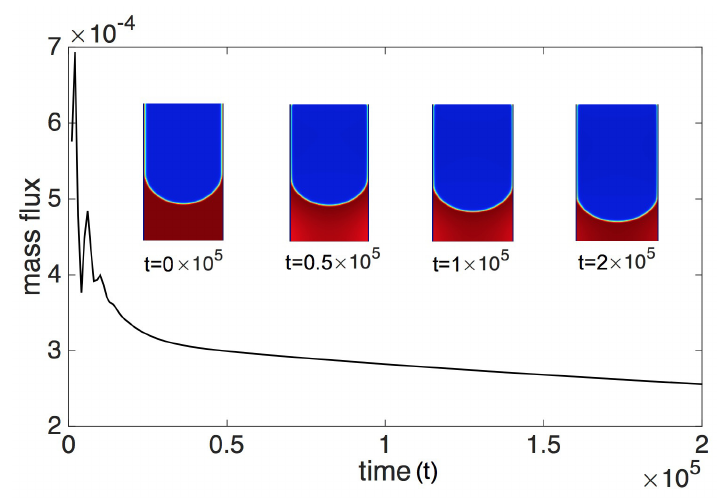
Figure 3. Evolution of the evaporating mass flux at the vapor outlet: mini plots demonstrate the density distribution at different time instants; the red part is liquid and the blue part is vapor; the computational domain is 101 × 200, and the heat flux imposed to the walls is 8 × 10 − 4 .